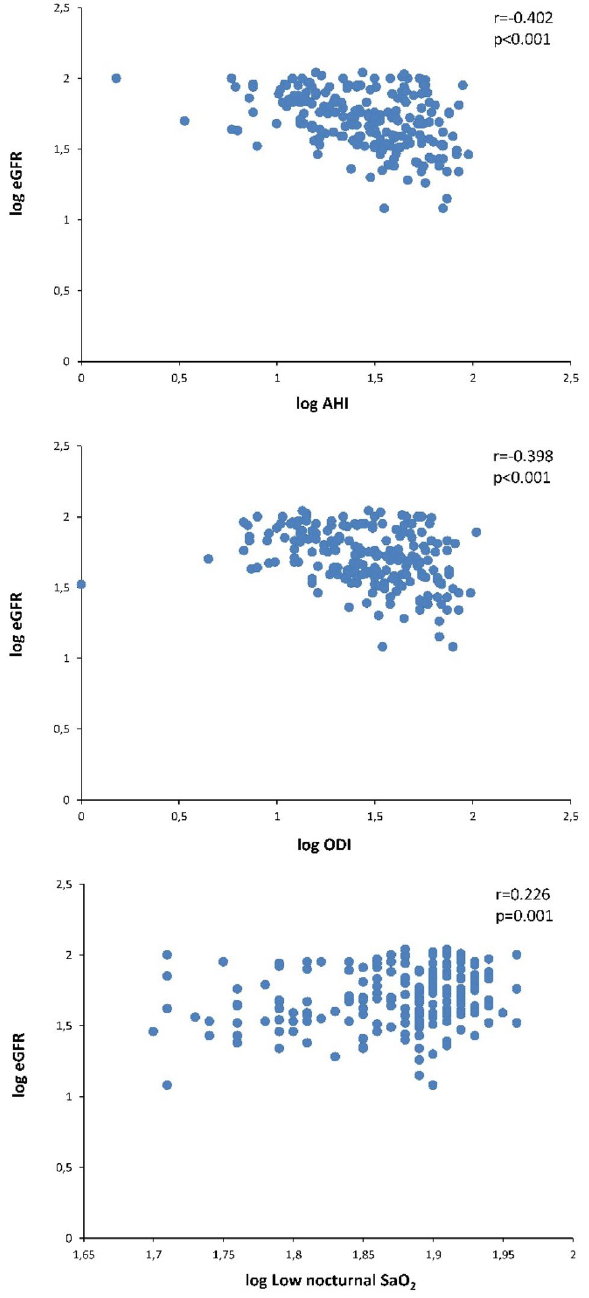
Figure 3. Relationship between the sleep characteristics and the estimated glomerular filtration rate (eGFR) in patients with diabetic kidney disease. Data are log transformed. AHI apnea–hypopnea index, ODI desaturation index, SaO 2 oxygen